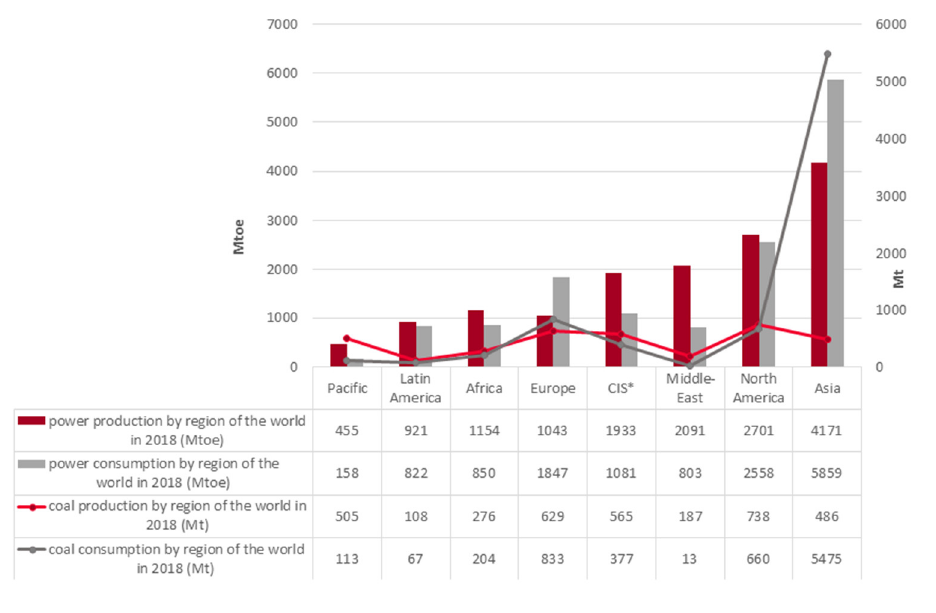
Figure 1. The global trend of energy and coal production/consumption in 2018 (based on [1]).